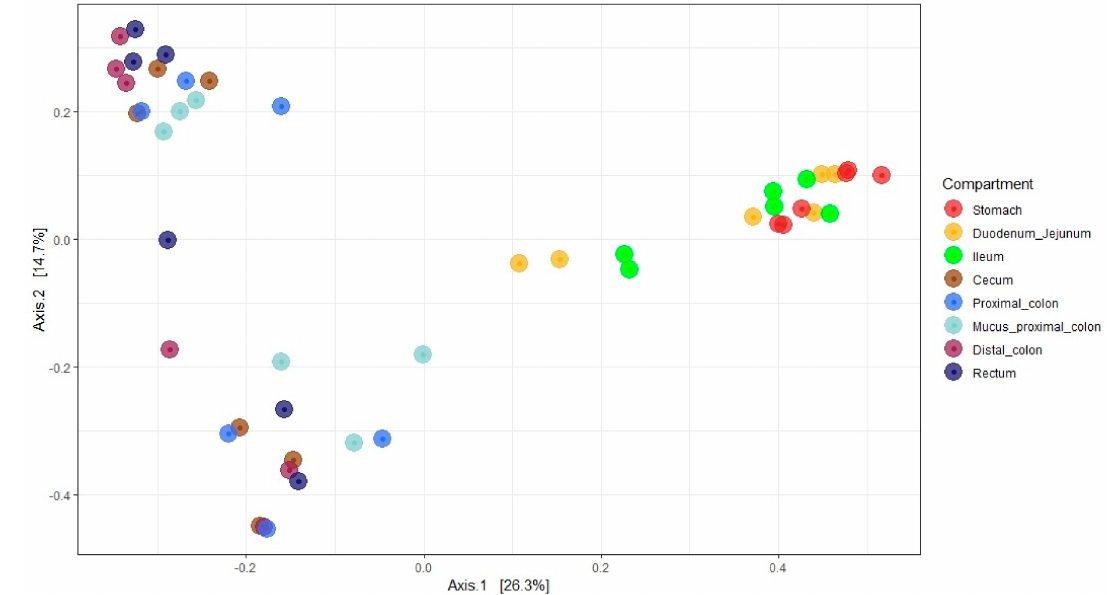
Figure 7. Bray Curtis multi-dimensional scaling / principal coordinate analysis of the bacterial communities across weaning piglet GI